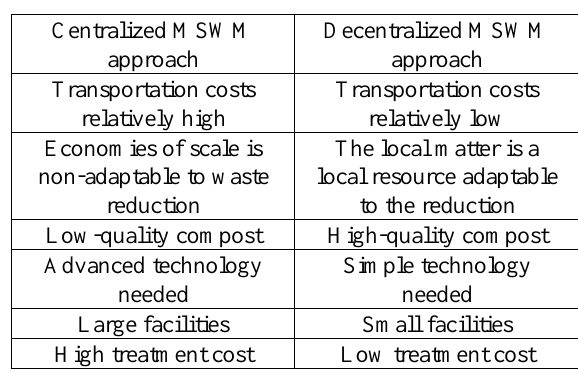
Table 1. Main differences between decentralized and